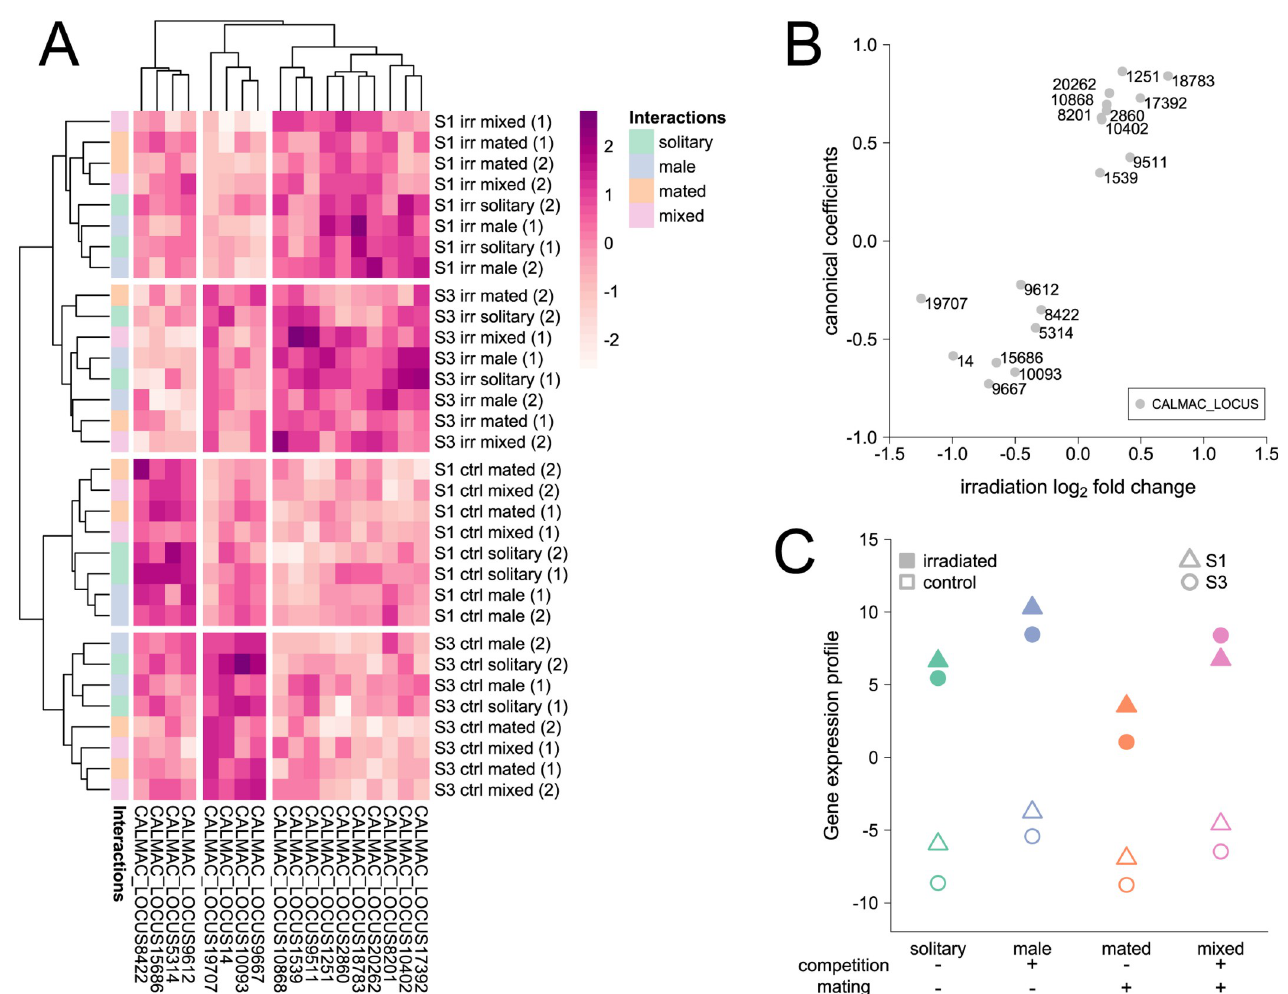
Fig 4. Gene expression in the reproductive tracts of S males. ( A ) Heatmap of scaled normalized log 2 expression of the 18 genes that responded to the irradiation treatment. Expression is clearly separated between irradiation treatments (ctrl: control, irr: irradiated) and experimental evolution lines (S1, S3). Within these blocks, a separation between mated (orange and pink) and nonmated (green and blue) males can be observed. ( B ) Canonical coefficients of the 18 irradiation responsive genes (that make up the canonical scores of each sample) against their log 2 fold change in response to irradiation. ( C ) Canonical scores separating control (open) and irradiated (closed) samples based on expression of the 18 irradiation responsive genes (triangles: S1; circles: S3). The data underlying this figure can be found at GEO under accession number